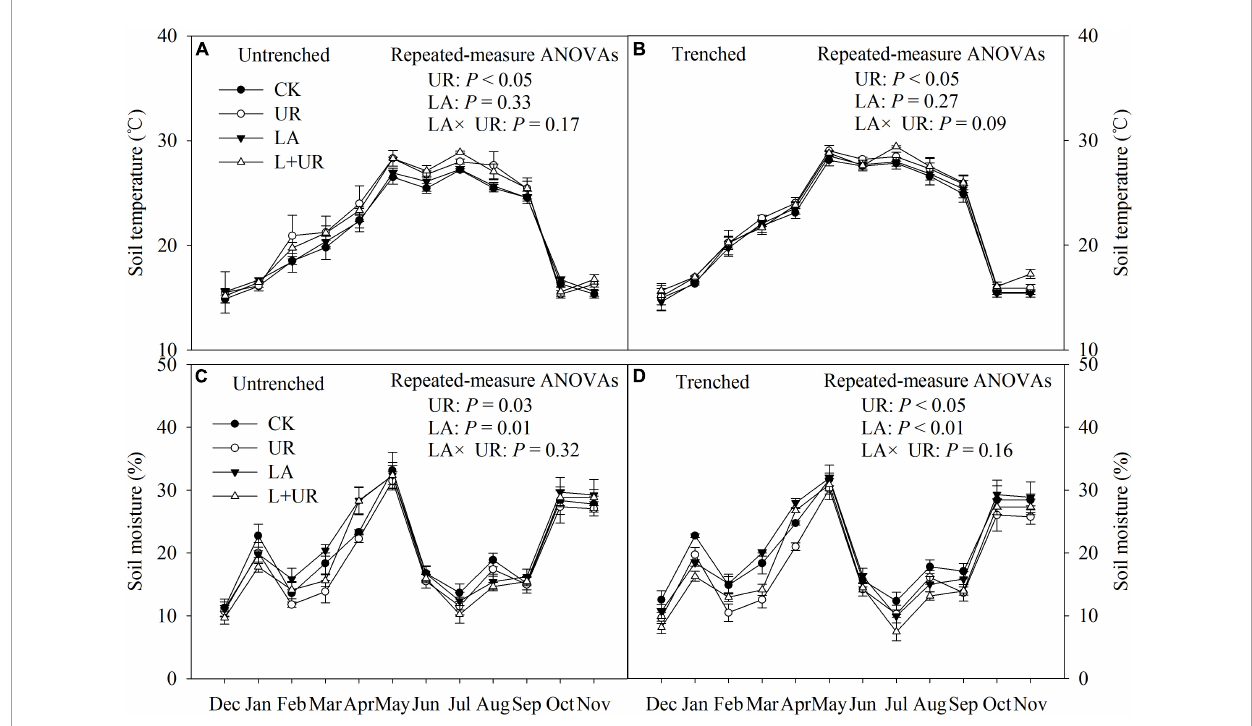
FIGURE3 (A,B) Are variations of soil temperature under different treatments in untrenched and trenched plot, respectively; (C,D) are variations of soil moisture under different treatments in untrenched and trenched plot, respectively, from December 2011 to November 2012. The inserted statistical results are from a two-way repeated-measure ANOVAs. Values are means with standard errors, n = 3.